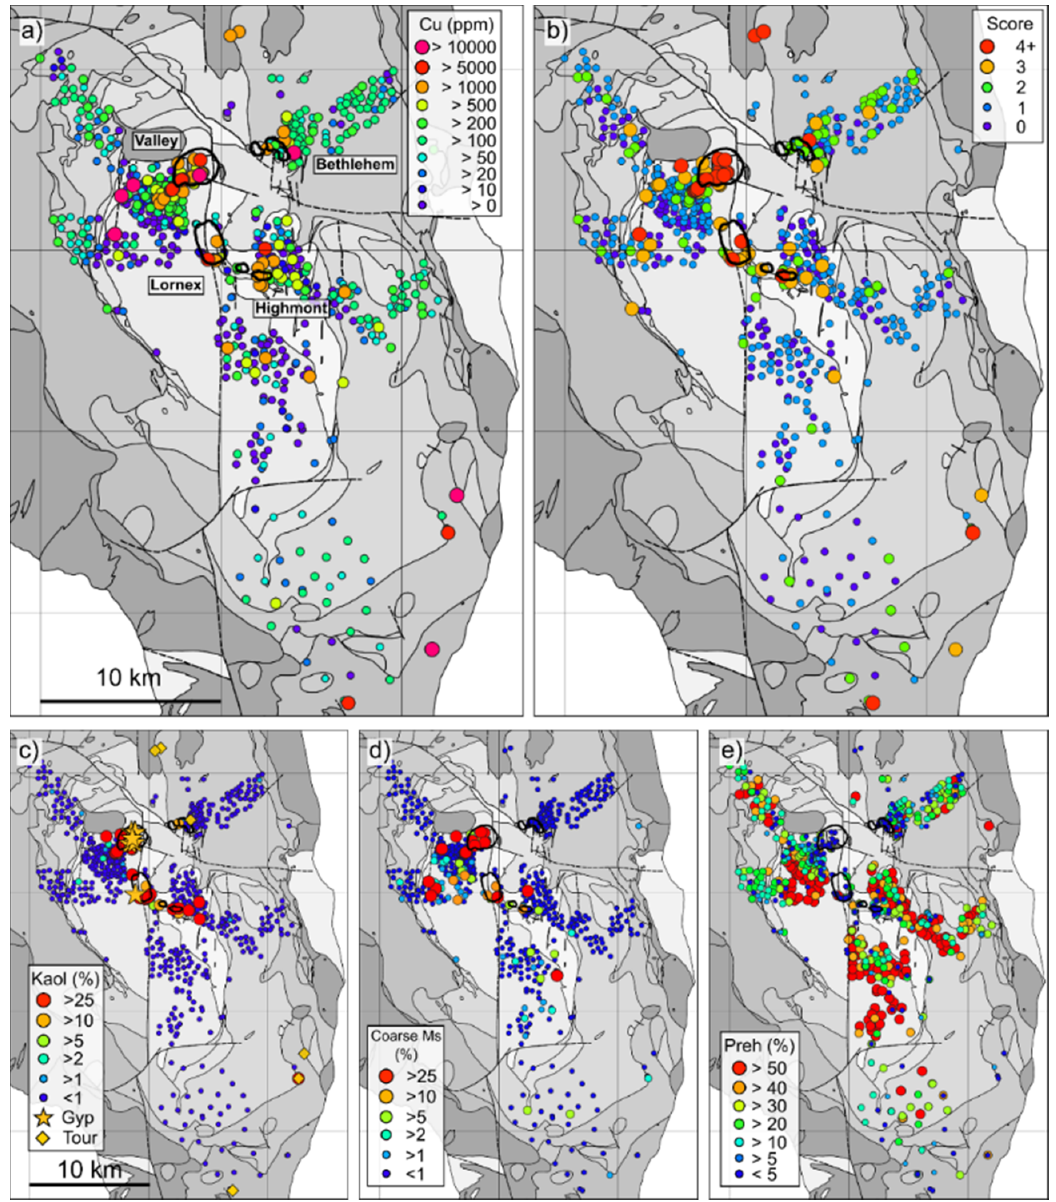
Figure 11. Regional map of the Guichon Creek batholith presenting data obtained from the 755 slab samples. ( a ) Copper concentration (in ppm) for all samples. Several small showings are present at the periphery of the batholith. ( b ) Spectral alteration score as defined in Table 2 (using all minerals). Spectrally derived relative modal abundance of; ( c ) kaolinite, with the presence of gypsum and tourmaline (>5%) indicated by stars and diamonds, respectively, ( d ) coarse grained white mica (>1 mm), and ( e ) prehnite. Geology and contacts after Figure 1.